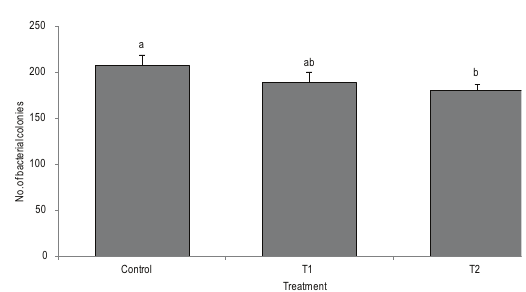
Fig. 6. Plasma bactericidal activity of tinfoil barb, Barbonymus schwanenfeldii , fed different levels of dietary probiotics (control, 0 CFU · g –1 diet; T1, 1 × 10 4 CFU · g –1 diet; T2, 1 × 10 6 CFU · g –1 diet) for 15 days; Data are presented as mean ± SE ( n = 9); Bars with dif- ferent letters were significantly different ( P <